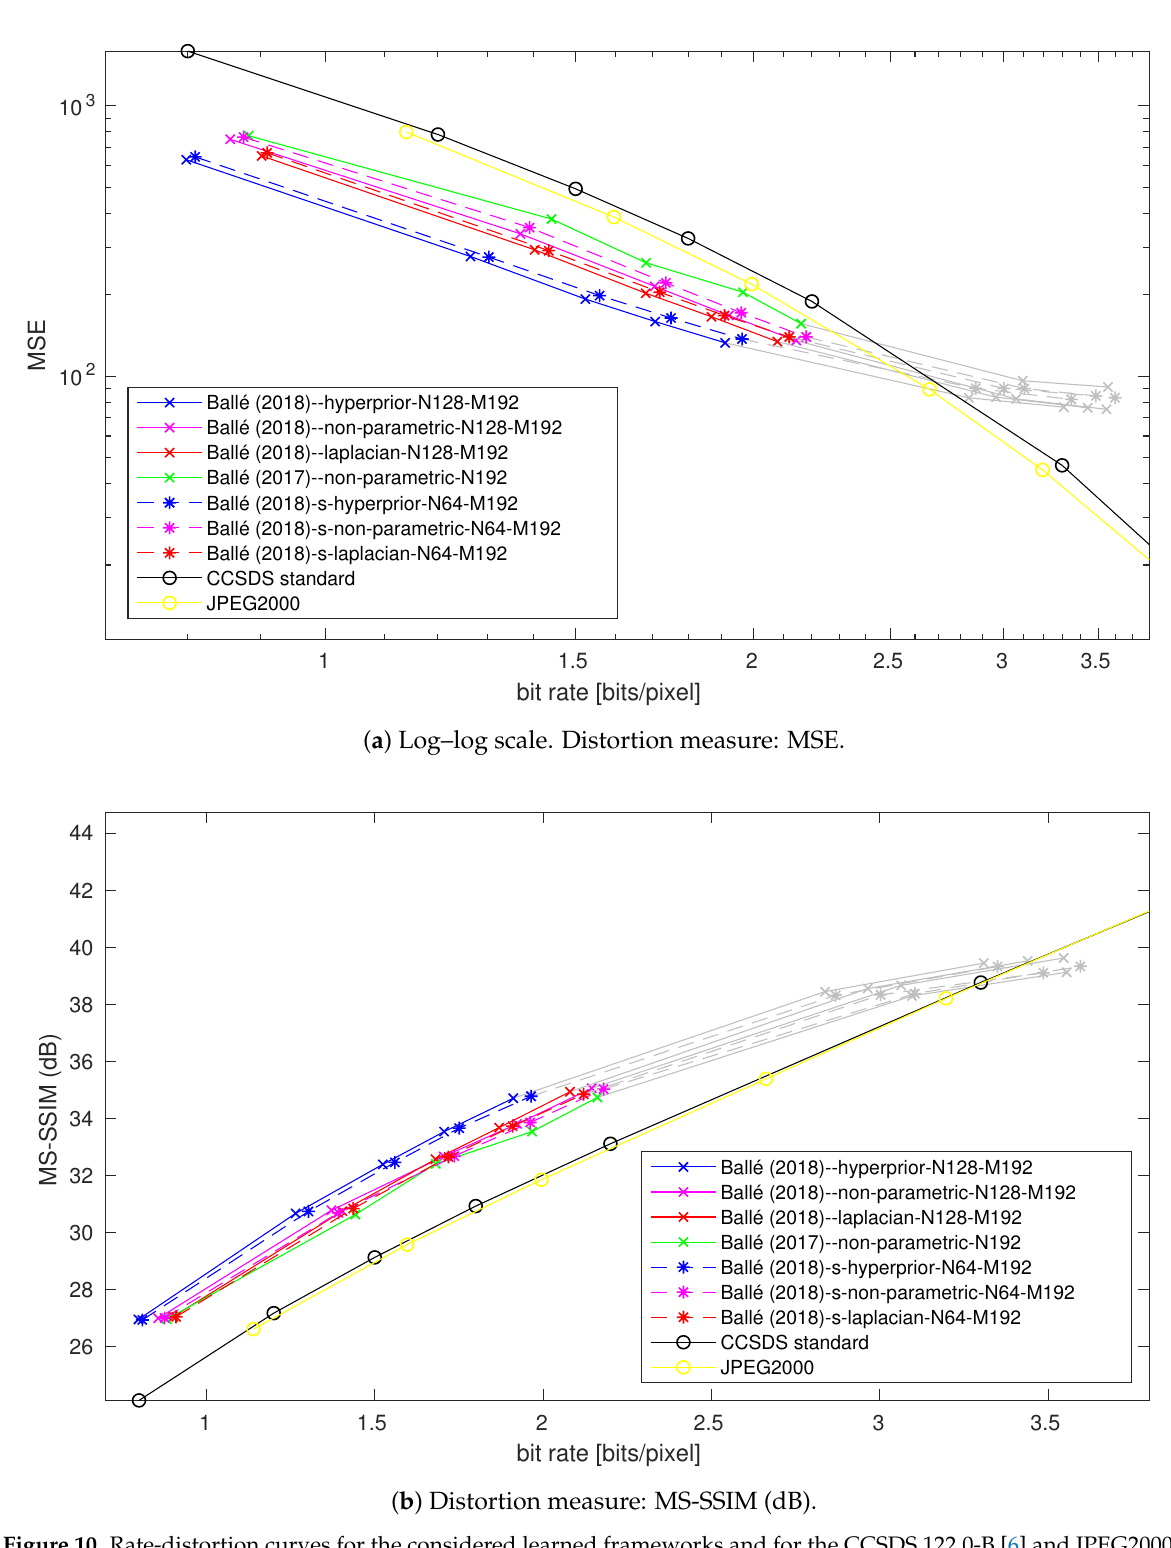
Figure 10. Rate-distortion curves for the considered learned frameworks and for the CCSDS 122.0-B [6] and JPEG2000 [5] standards in terms of MSE and MS-SSIM (dB) (derived as − 10log (1 − MS-SSIM))-Case of rates up to 2 bits/pixel. 10 As expected, Ballé(2018)-s-hyperprior–N64-M192 achieves a rate-distortion per- formance close to the one of Ballé(2018)–hyperprior-N128-N192 [16], both in terms of MSE and MS-SSIM, for rates up to 2 bits/pixel. We can conclude that the decrease